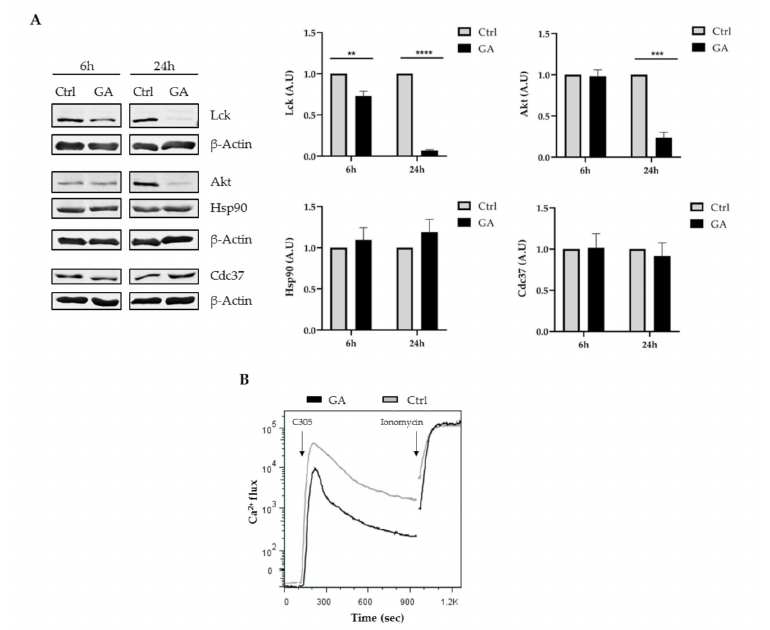
Figure 4. Inhibition of heat shock protein 90 (Hsp90) activity affected Lck expression and TCR signaling. JE6 cells were either left untreated (Ctrl) or treated with geldanamycin (GA) for 6 h or 24 h. Cell lysates were analyzed by immunoblotting using the indicated antibodies. ( A ) Immunoblot showing the expression of the indicated molecules. Bands in ( A ) were quantified using the Im- ageStudio software and values were normalized to the corresponding β -actin signal. Graphs show the expression levels of the indicated molecules as arbitrary units ± SEM of three independent experiments. ( B ) JE6 cells were either left untreated (Ctrl) or treated with geldanamycin for 6 h. Sub- sequently, JE6 cells were incubated with Indo-1AM and stimulated with the TCR clonotypic antibody C305, and Ca 2+ flux was measured by flow cytometry. Ionomycin was used to induce maximum Ca 2+ flux. Significat p -values were calculated using the Student’s t -test (**, p < 0.01; ***, p < 0.001; ****, p <